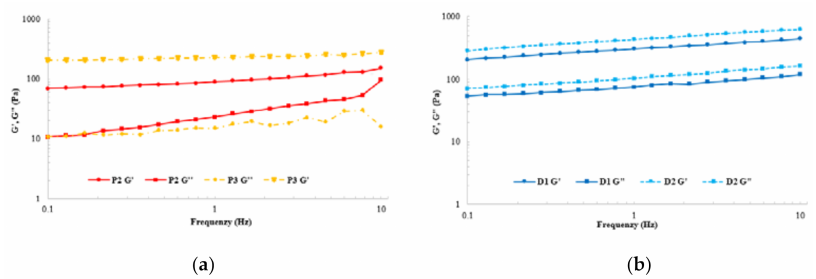
Figure 3. An example of the viscoelastic properties of both types of the following samples: plant- based samples P2 and P3 in Figure ( a ) and dairy samples in Figure ( b